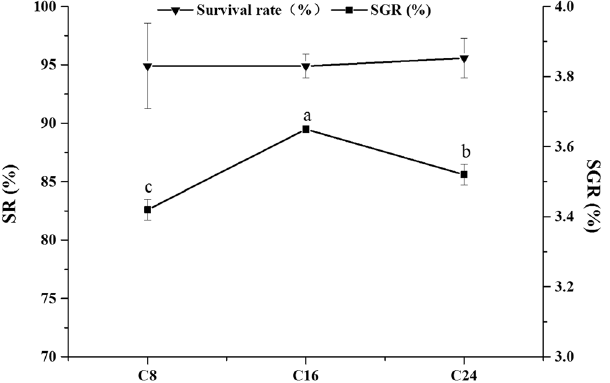
Figure 1. Survival rate (SR) and the specific growth rate (SGR) of Japanese flounder after the 10-week feeding trial. The values represent the means ± S.D., n = 3. Values with different letters mean significantly different ( P <